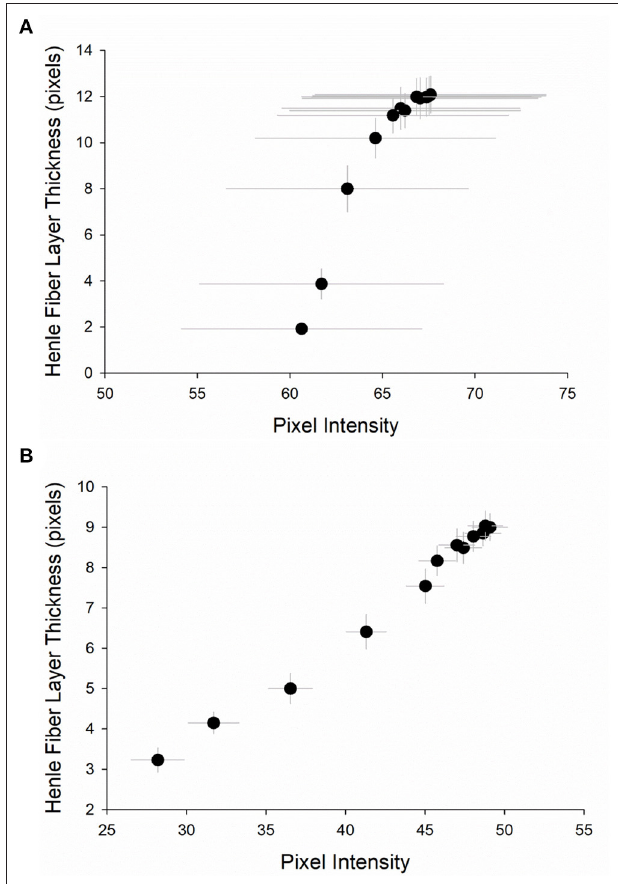
FIGURE 8 | Representation of the relationship between pixel intensity and Henle fiber layer thickness (A) in the first cohort ( n = 11) and (B) in the second cohort ( n = 22). Circles are the mean at each of the 12 eccentricities, from 0 ◦ to 3 ◦ (0.25 ◦ steps) in the central macula. Vertical and horizontal error bars are the standard error of the